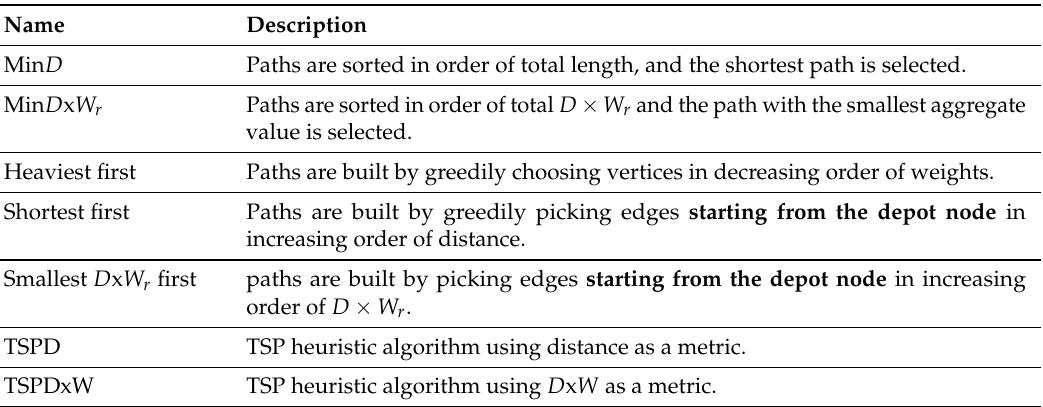
Table 1. Exhaustive exploration of paths: list of